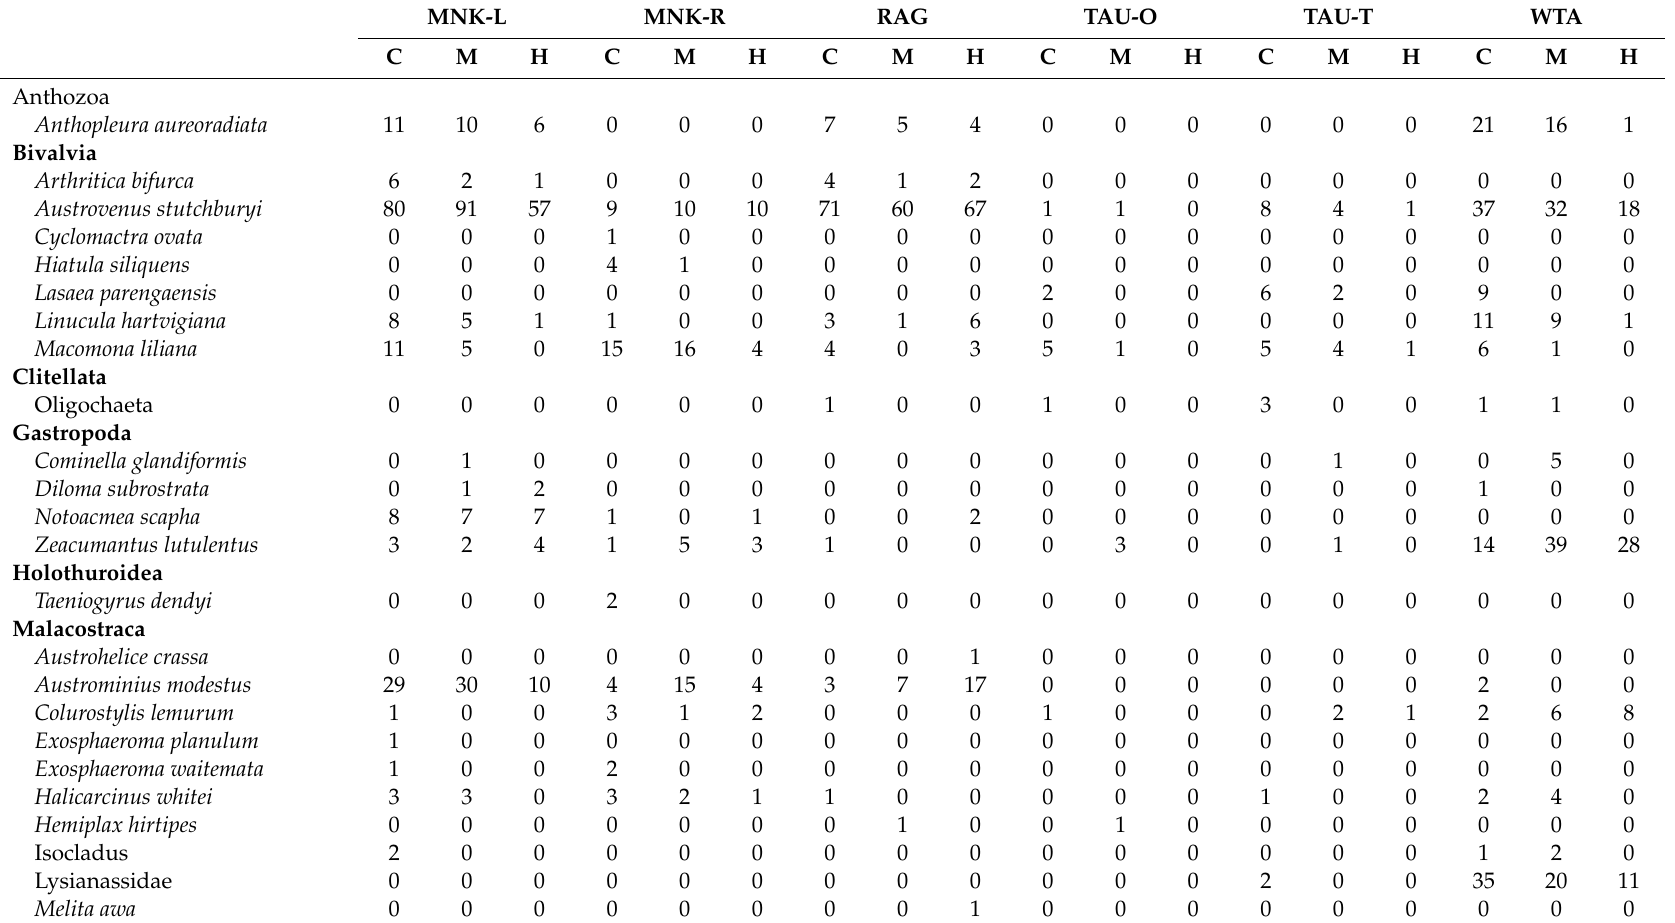
Table A4. Average abundance (n core − 1 ) of taxa as a function of nutrient enrichment treatment in November 2018 (T3; n = 3). Treatments have been abbreviated to C = control, M = medium, H =